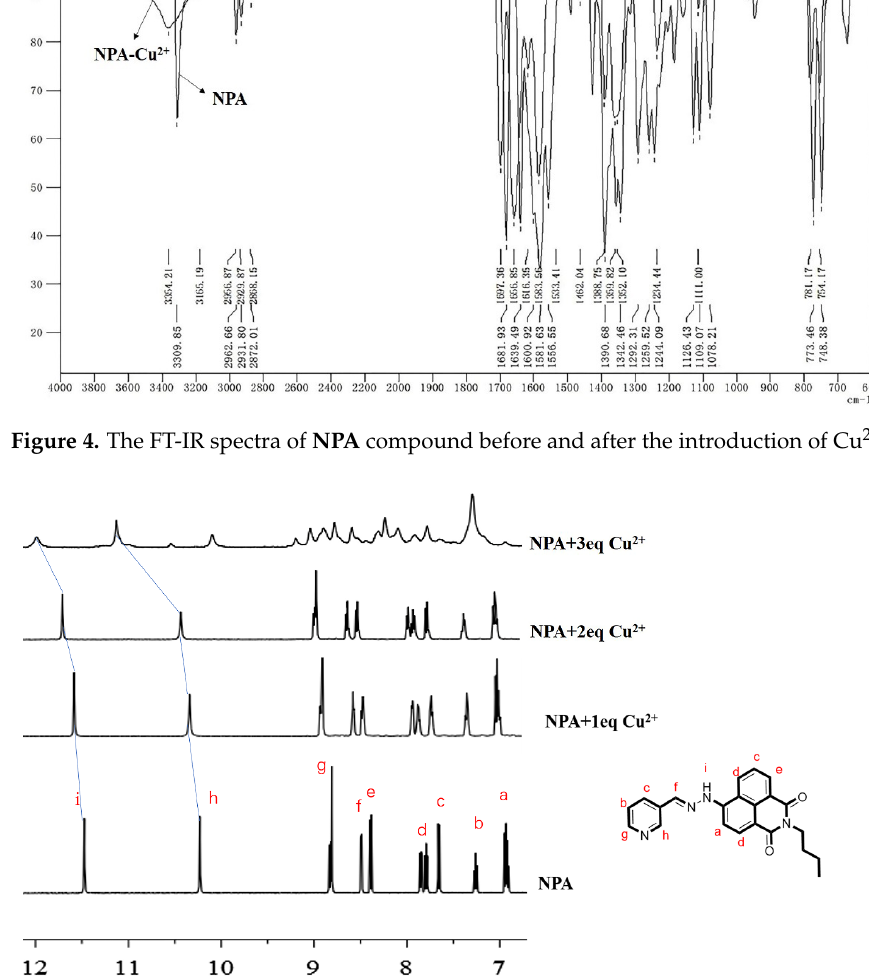
Figure 5. 1 H NMR titration plots of NPA probe with Cu 2+ in DMSO- d 6 . (a, c, d, e: naphthalimide; b, c, g, h: pyridine; f: CH−N; i: NH..